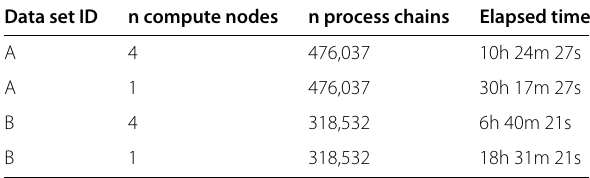
Table 4 Results of our evaluation with the Montage